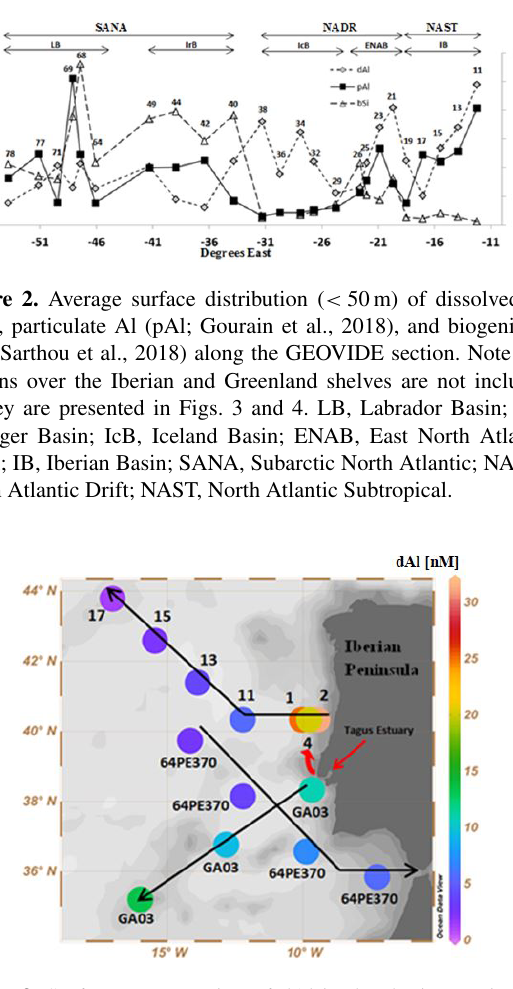
(dAl: [ F( 3 , 17 ) = 0 . 89, p = 0 . 46]; pAl: [ F( 3 , 17 ) = 1 .